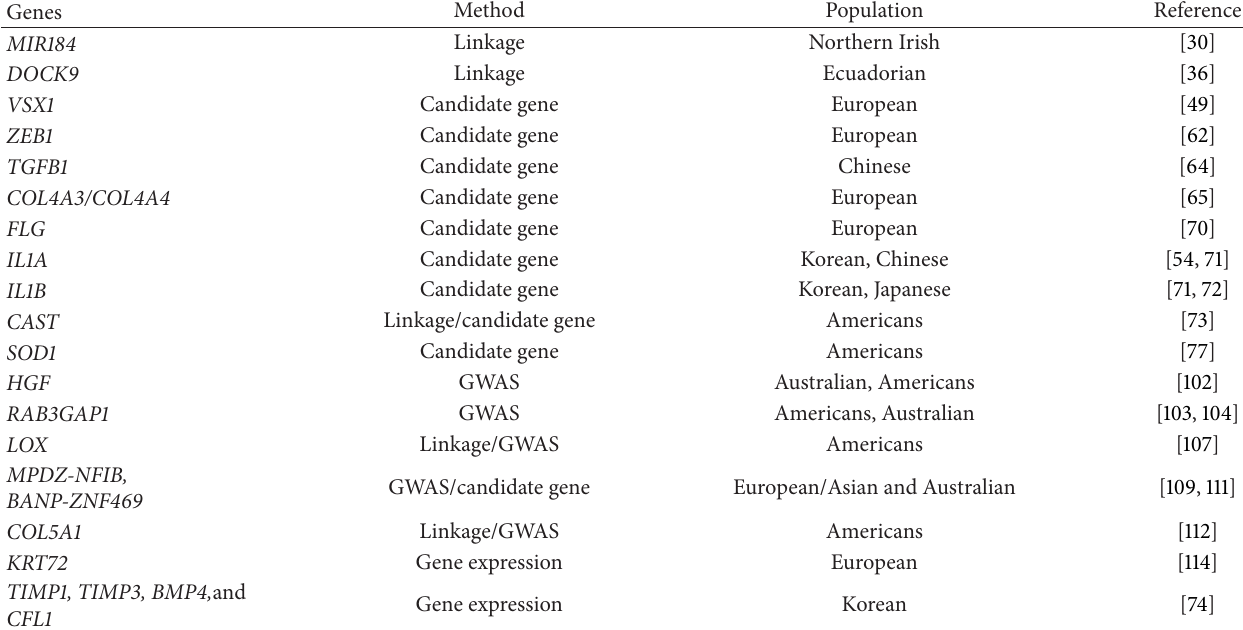
Table 2: Some of the genes reported in keratoconus using different genomic